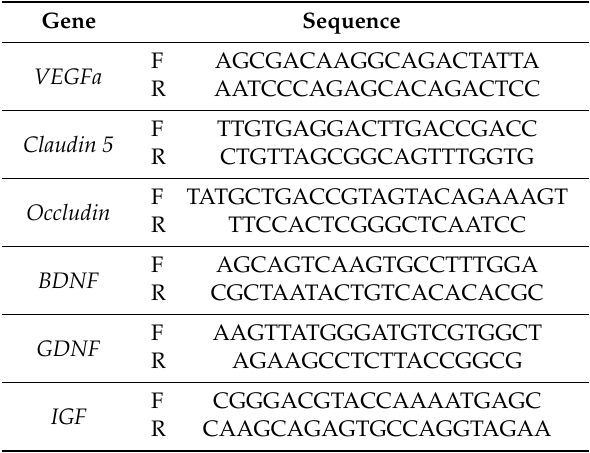
Table 2. Gene primer sequences used for RT-PCR.